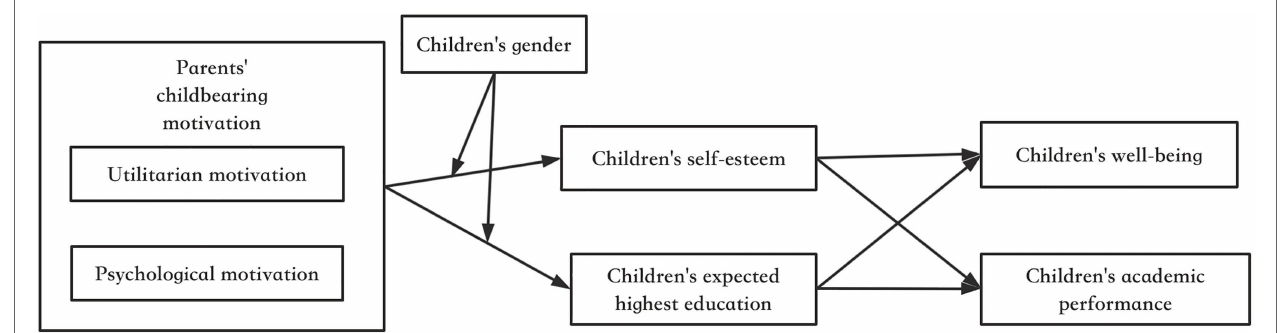
FIGURE 1 | An analytical model with children’s psychological factors as mediators in Study 2.